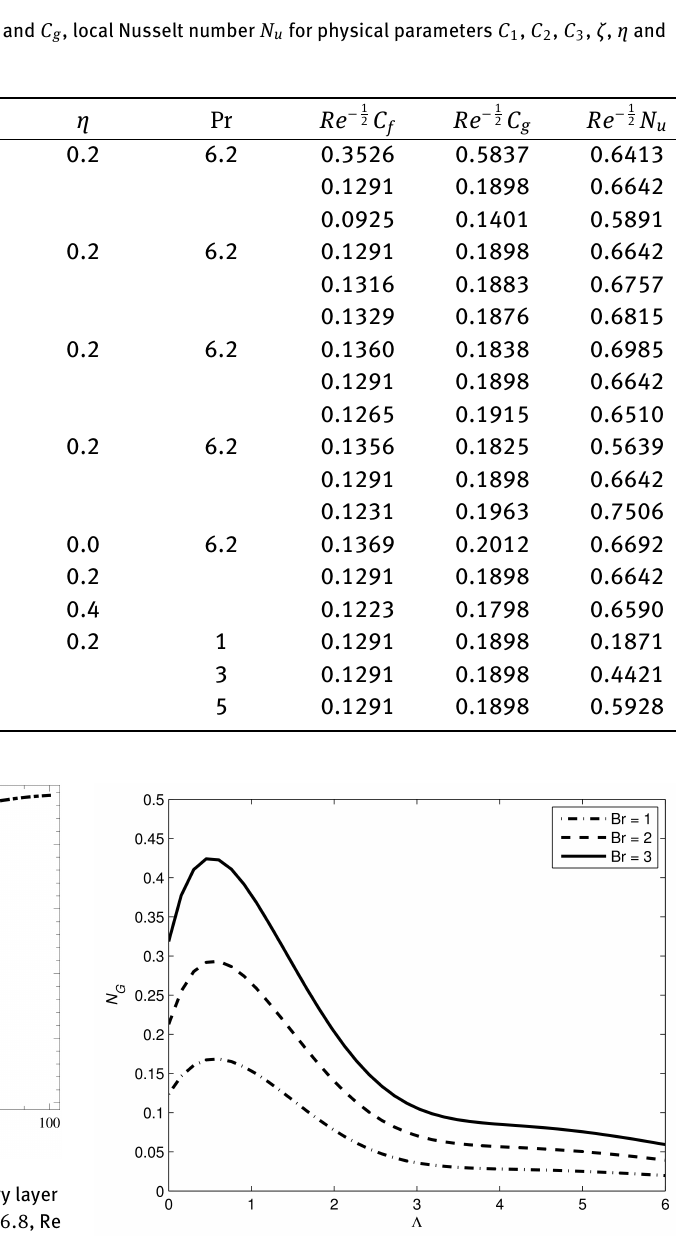
Figure 23: Effect of Br on N G keeping ζ = η = 0.2 , C 1 = C 2 = C 3 = 10 , Br = 1 , Pr = 6.8 , Re = 2950 , σ 1 = 1 , σ 2 = 0.5 , Q 0 = 0.5 ber. Therefore, fluid velocity increases with increase in the tangential slip parameter. Finally, it is observed that varia- tions in the Prandtl number Pr change the Nusselt number only, which reduces heat transfer as the Nusselt number increases. For the reliability of numerical outcomes, comparison of the present results with [24] is presented in Table 2. It can be seen that the results are in good agreement at C 1 = C 2 = C 3 = ζ = η = 0, which validates the